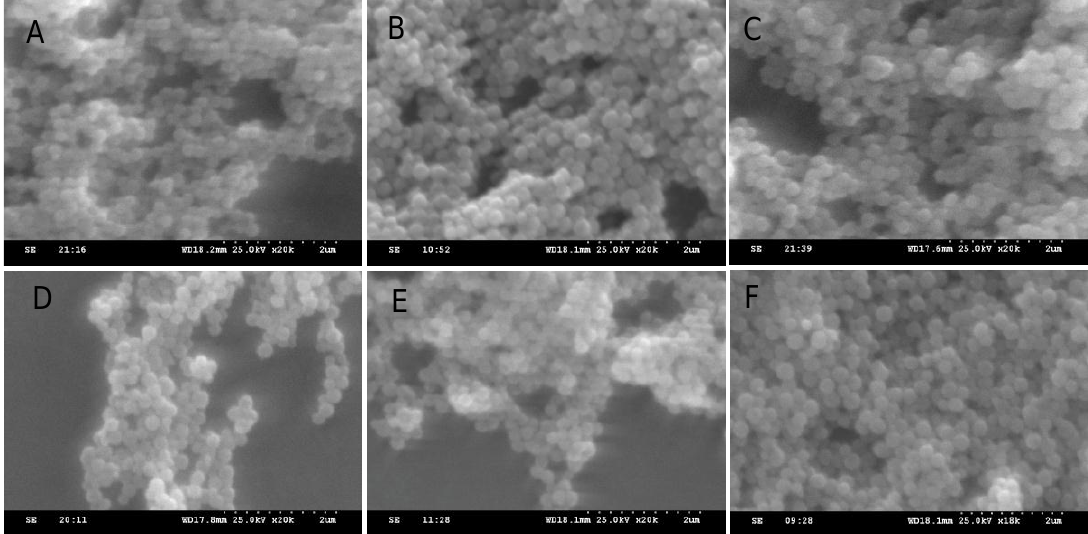
Figure 9. SEM images of Fe 3 O 4 with different reaction time, ( A ) 5 h, ( B ) 6 h, ( C ) 8 h, ( D ) 10 h, ( E ) 12 h, ( F ) 20 h.